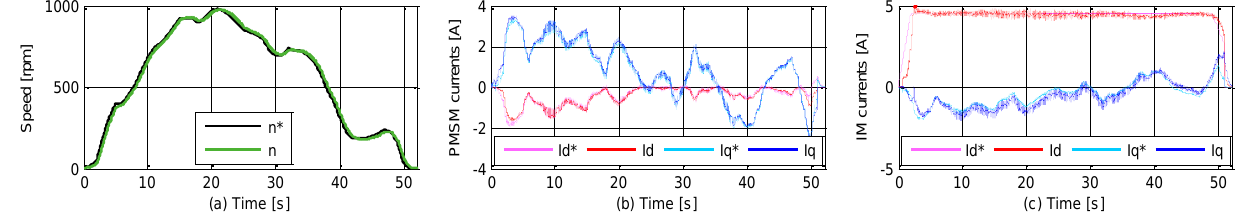
Figure 10. ARTEMIS driving cycle laboratory test (only the first 52 s are